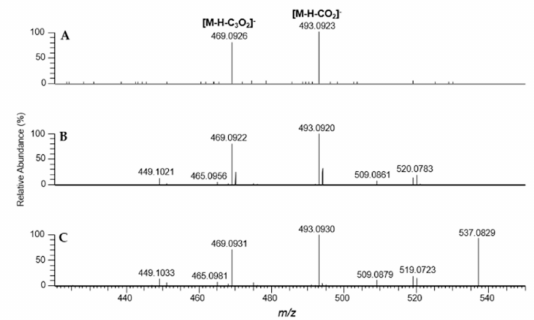
Figure 4. HPTLC-DESI-HR-MS 2 data of skyrin (6); ( A ) from fungal extract of Cortinarius (D.) austronanceiensis (NCE:50%); ( B )skyrinstandard(NCE35%); ( C )directinfusionESI-HR-MS 2